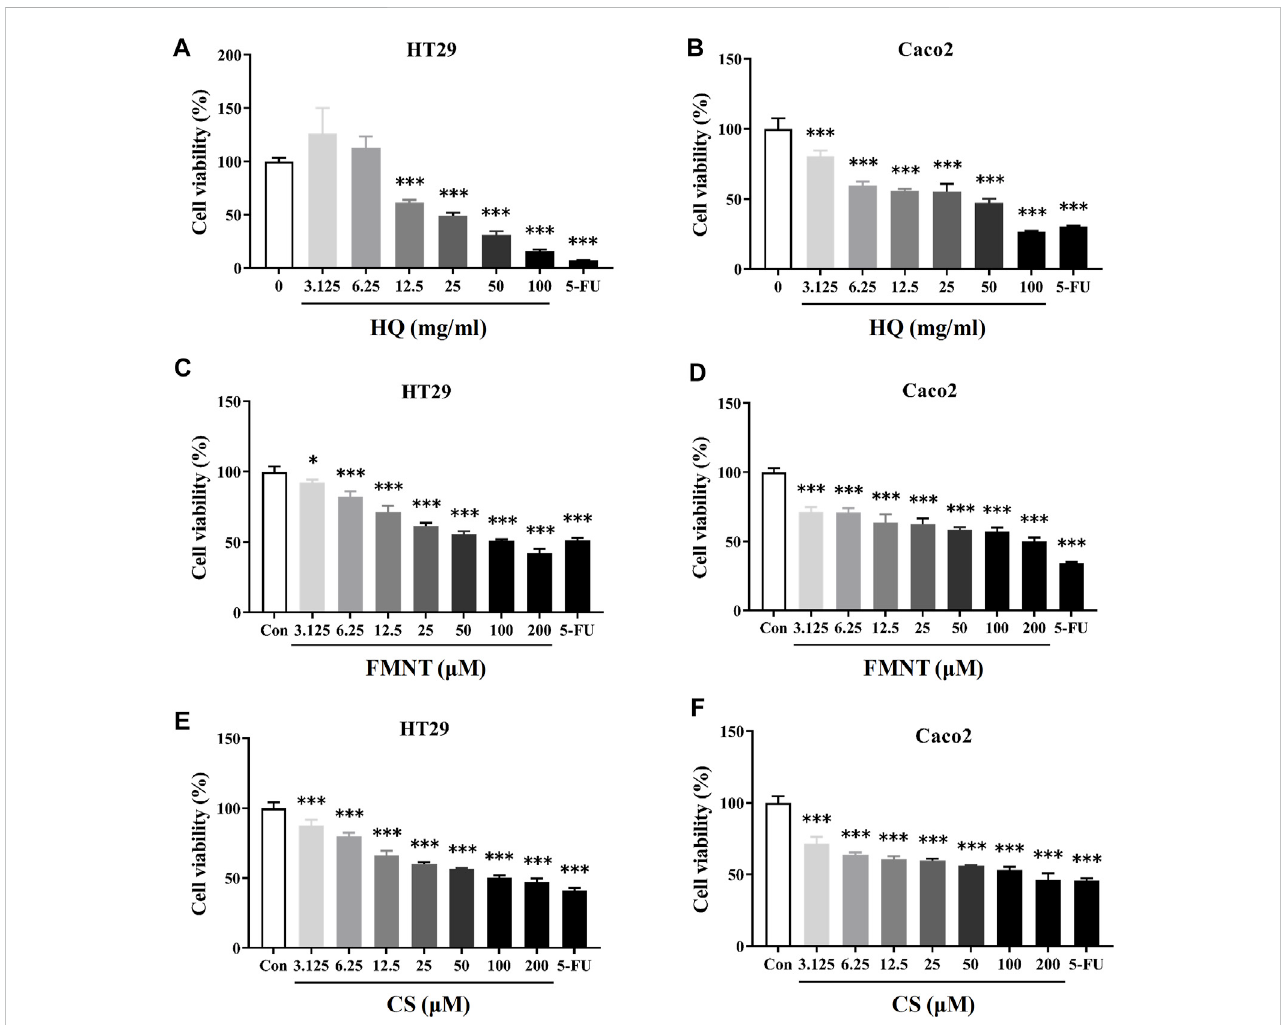
FIGURE 5 HQ, FMNT and CS signi fi cantly inhibited the viability of HT29 and Caco2 cells. The cytotoxicity of HQ (3.125 – 100 mg/mL, 48 h) (A and B) , FMNT (3.125 – 200 μ M, 48 h) (C and D) and CS (3.125 – 200 μ M, 48 h) (E and F) toward HT29 and Caco2 cells, respectively. 5-FU was used as a positive control for inhibition of cell viability. The data represent the mean ± SD ( n = 3). * p < 0.05 and *** p < 0.001 compared with the control